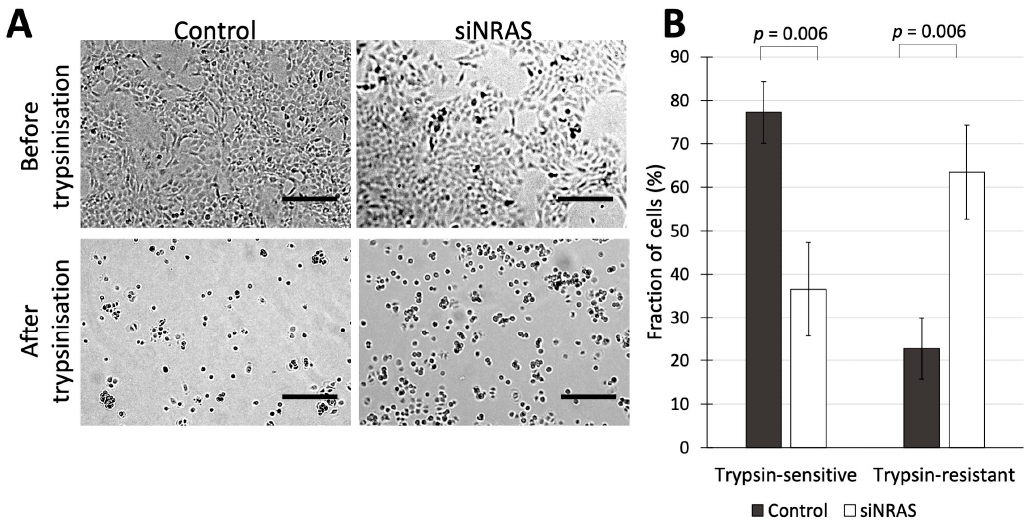
Figure 3. ( A ) hPheo1 cells transfected with control-siRNA or siRNA against NRAS (control and siNRAS#1, respectively), before and after trypsinization for 1 min. Scale bars represent 250 μ m. ( B ) Cell counts for hPheo1 cells that were detached or remained attached (trypsin-sensitive or trypsin-resistant, respectively) after 1 min of trypsinisation, expressed as percentages of total cell number (mean ± standard deviation, n = 3). p values calculated with student’s T -test.